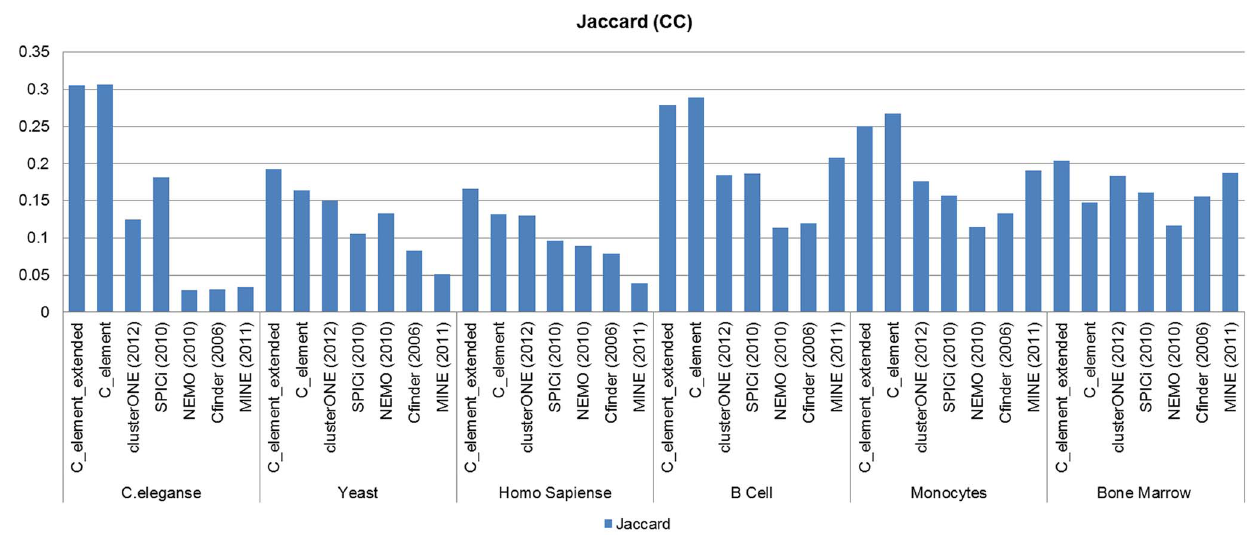
Figure 7. The results of Jaccard measure analyses on the results of different algorithms on different network datasets when GOCC derived functional modules were considered.